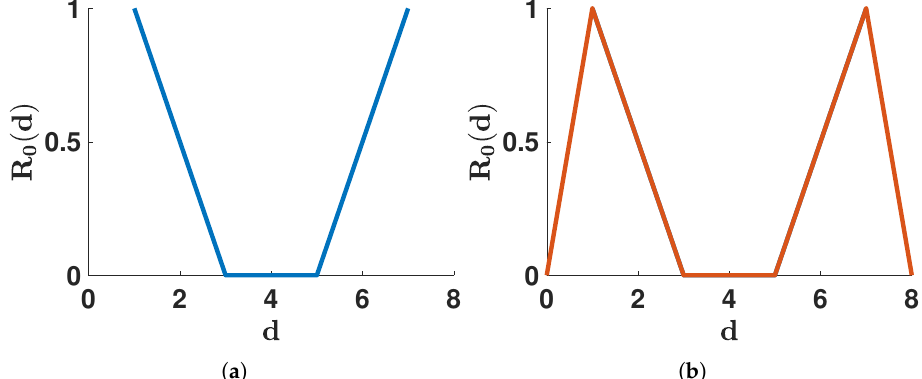
Figure 1. In this figure, we illustrate the notion of U shape distribution in ( a ) and M shape distribution in ( b ). Recall that R 0 ( d ) represents the ability of patients to transmit the pathogen after d days since they were infected. The U shape or M shape distribution means that patients can transmit the pathogen since the beginning of their infection. Then they become less infectious in the middle of the infected period. Finally, they become infectious again at the end of the infected period. The only difference between U and M shape distribution is to include days 0 and 8 and R 0 ( 0 ) = R 0 ( 8 ) = 0 in the